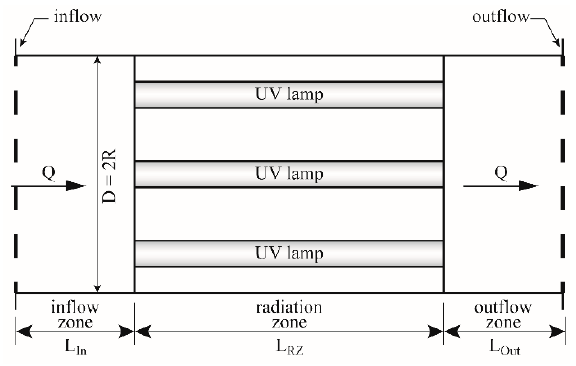
Figure 1. Structural scheme of a typical UV flow reactor.